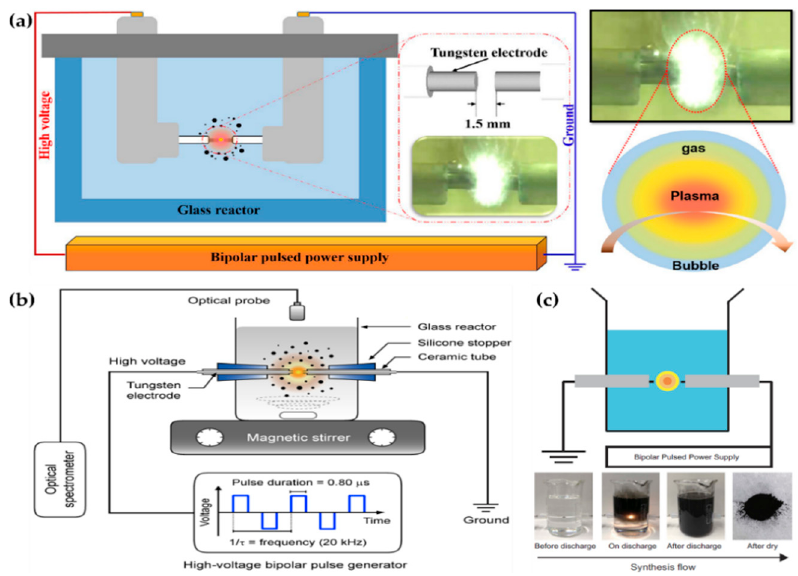
Figure 10. Representative figures on the generation of the in-solution plasma systems of ( a ) Hyun Figure